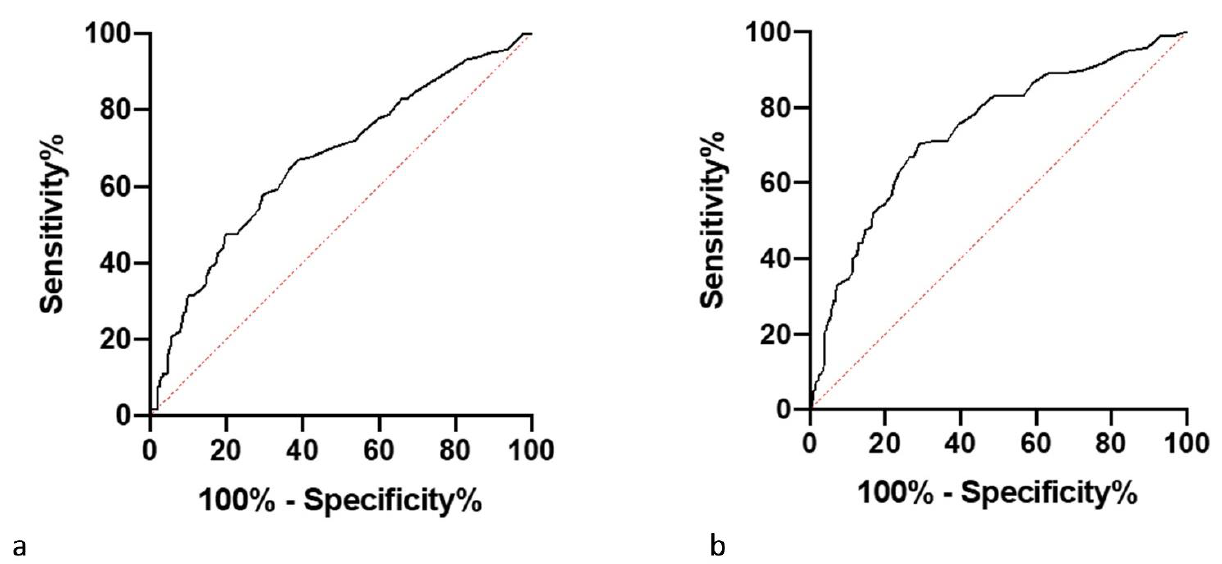
Figure 10. ( a ) An ROC curve showing the sensitivity and specificity of different threshold values in determining whether a cow is lame based on the data collected of the difference between the hind foot temperatures, calculated from the residuals from the average healthy foot temperature on each data collection day collected by the CAT s62-Pro Smartphone (LCD). ( b ) An ROC curve showing the sensitivity and specificity of different threshold values in determining whether a cow is lame based on the data collected of the difference between the hind foot temperatures, calculated from the residuals from the average healthy foot temperature on each data collection day collected by the FLIR T620bx